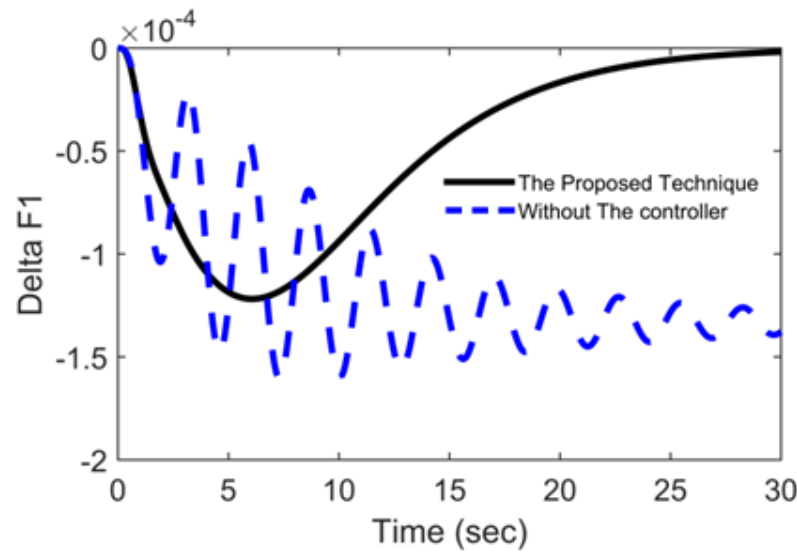
Figure 3. Frequency deviation (p.u.) in area 1.